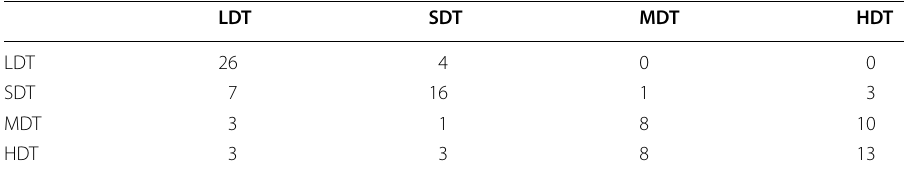
Table 8 Confusion matrix for the Naïve Bayes Predictor